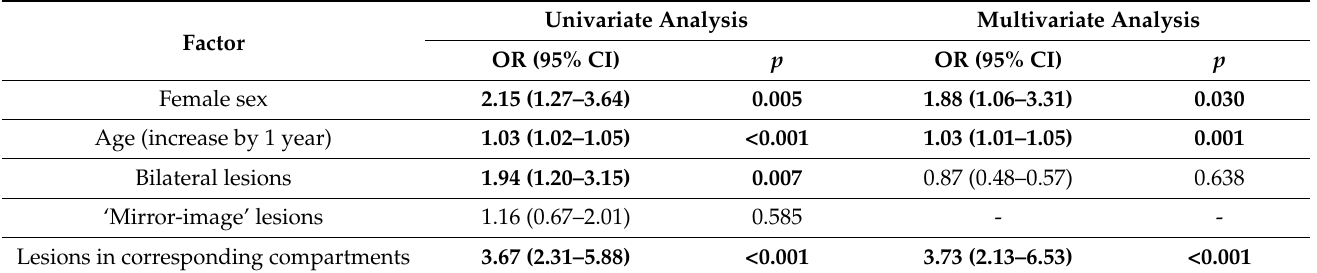
Table 5. Logistic regression for the dependent variable of seropositive RA vs. the independent variable of PsA considering the types of symmetry. Variables that were significant in the univariate analysis were included in the multivariate model.